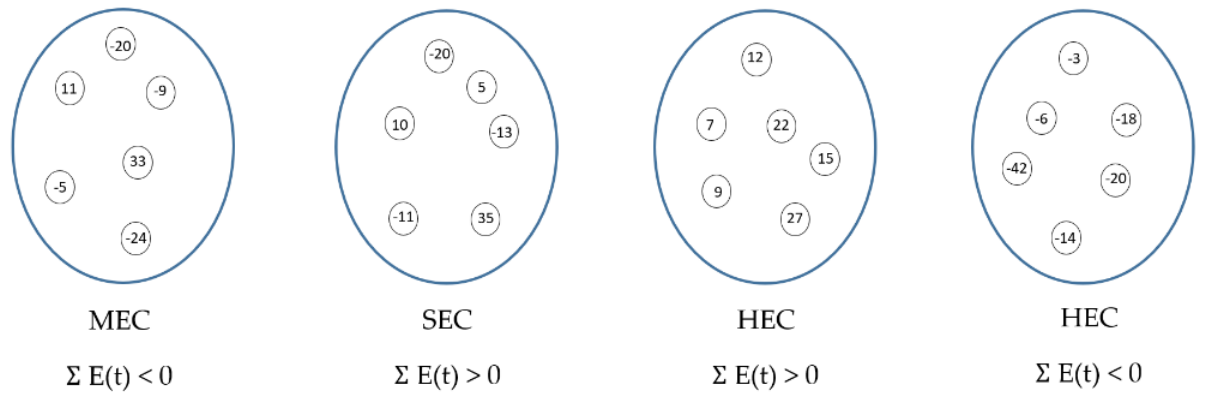
Figure 1. Comparison of the net energy of the different types of RECs.